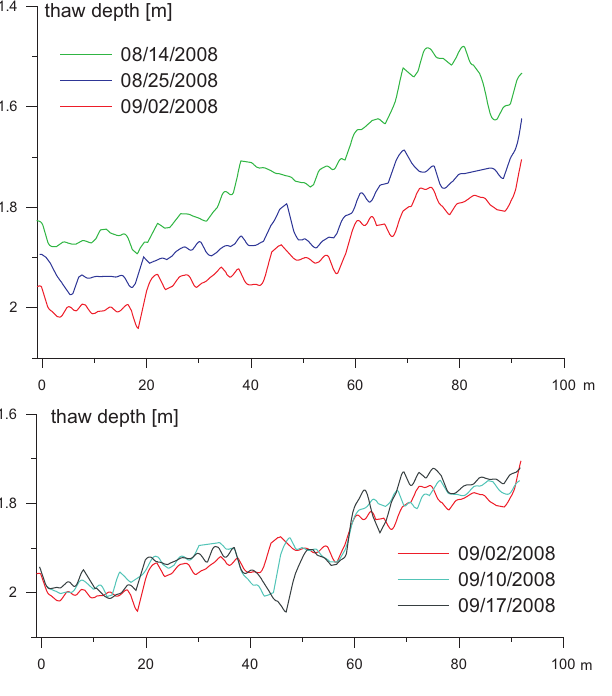
Fig. 5. Transect T2: thaw depth inferred from multi-channel-GPR over a transect length of about 175m. For unknown reasons, the survey of transect T2 conducted on 2 September yields only a weak and discontinuous reflection to about the 40m mark, so that it is not possible to infer meaningful thaw depths for this part of the transect. The arrow indicates the position of the instrumented temperature profile (Fig.